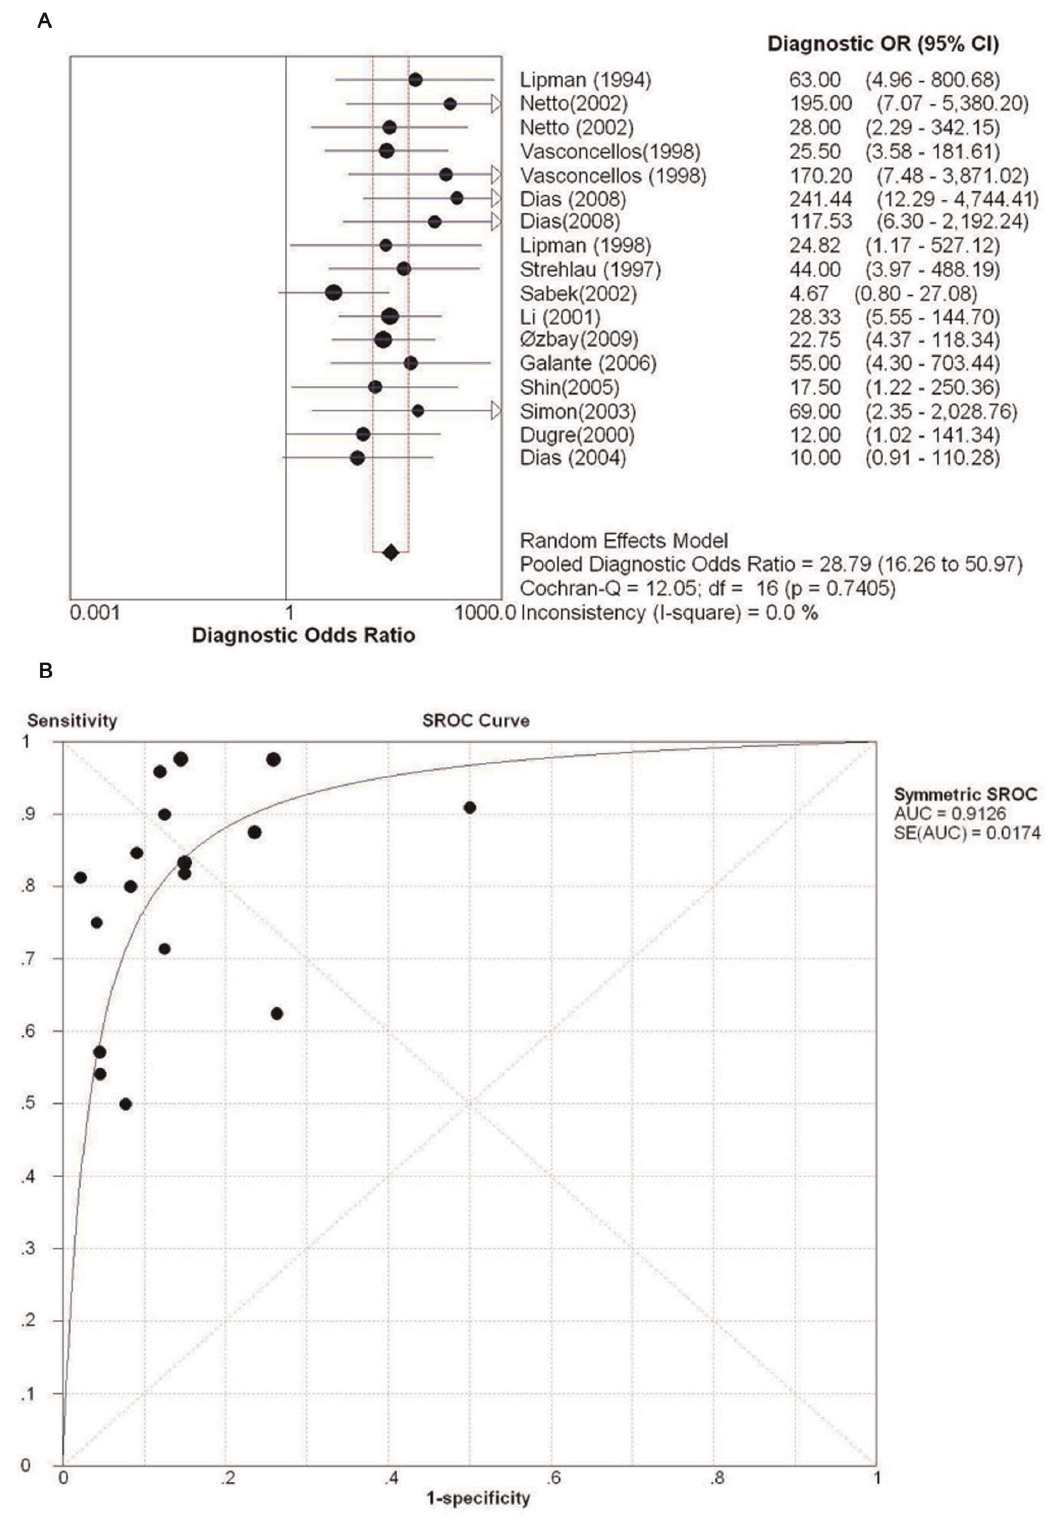
Figure 3. Overall DOR and SROC curves for all data sets describing the diagnostic performance of perforin mRNA detection in identifying AR. (A) Overall DOR. (B) The SROC curves for all data sets. Effect sizes were pooled by random-effects models. The pooled DOR is shown as a solid diamond. Each square in the SROC curve represents one study. Sample size is indicated by the size of the square.